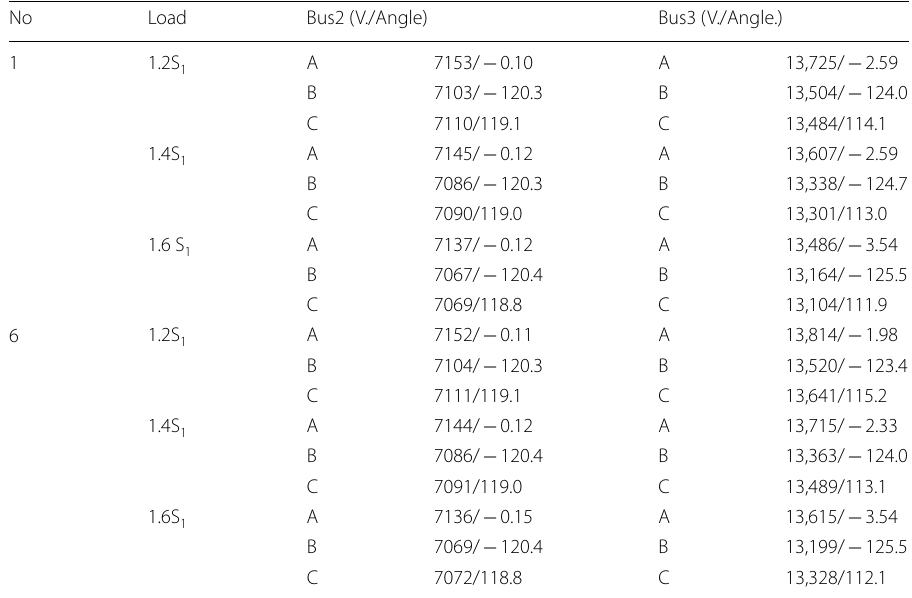
Table 5 Results for power flow calculations for the transformers (YN, yn 0 connection) in different loads No